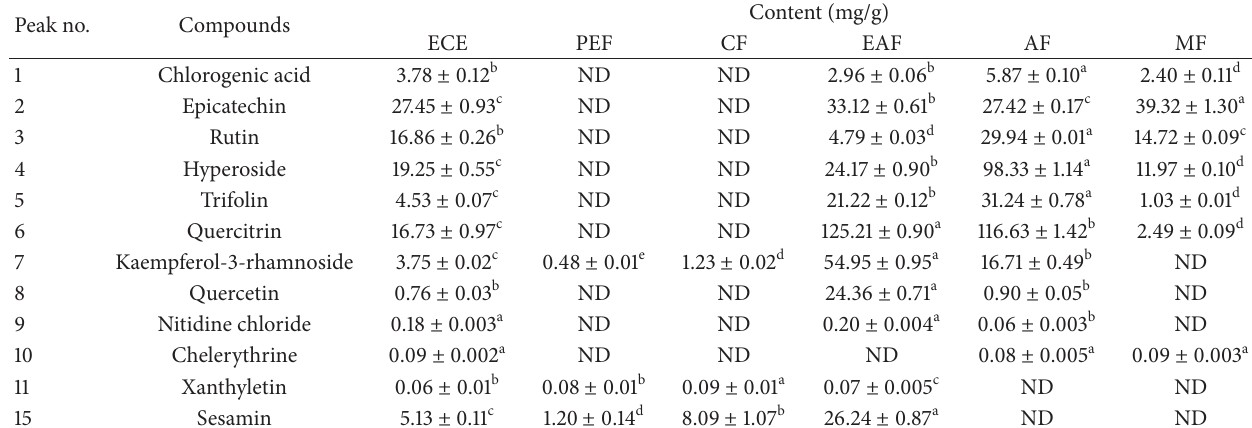
Values are the mean of three replicates ± SD. Means with different letters within a row were significantly different ( 𝑃 < 0.05 ). ND: not detectable.